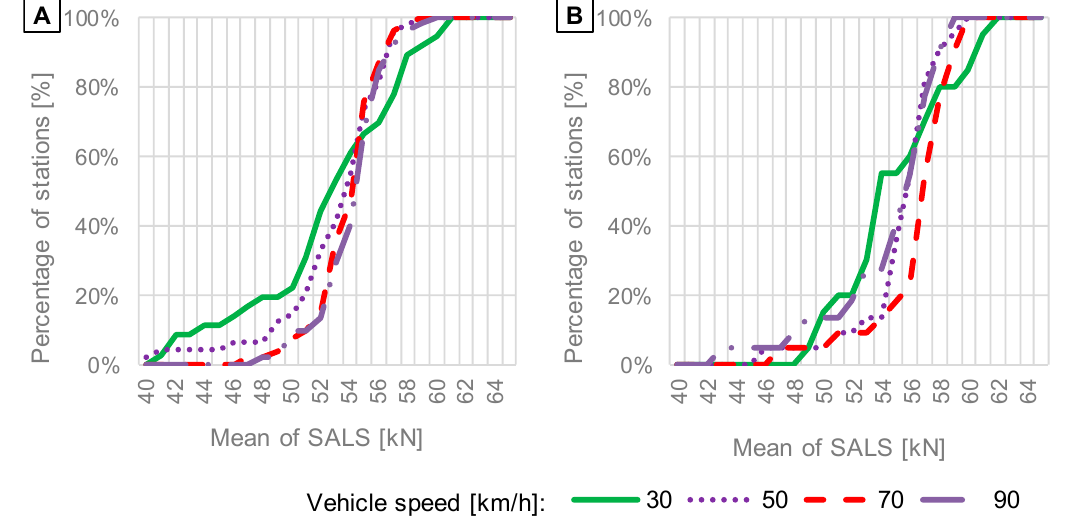
Figure 9 . Distributions of means of SALS in relation to vehicle speed based on data from WIM systems equipped with: ( A ) quartz piezoelectric; ( B ) bending beam axle load sensors.